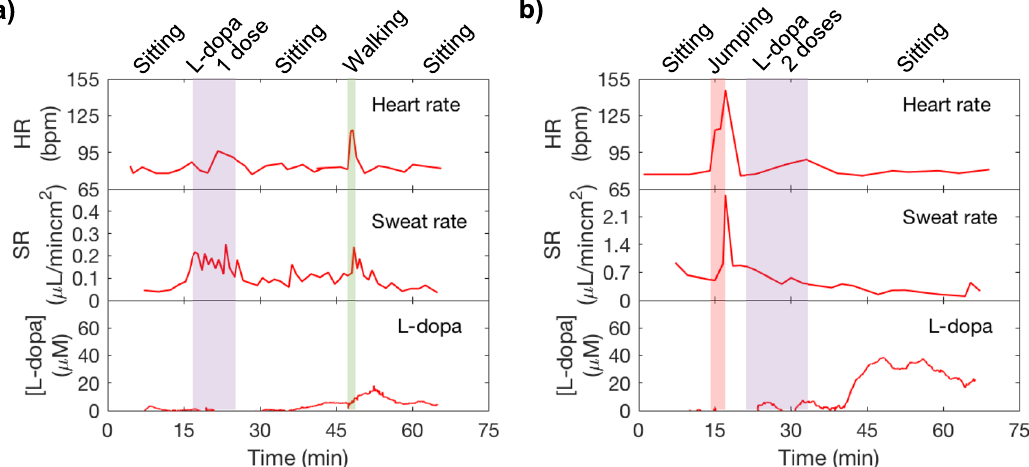
Fig. 7 In situ sweat analysis to assist Parkinson ’ s disease management on daily basis. A healthy subject wore the micro fl uidic patch on the fi nger and had broad beans intake of ( a ) 1 dose = 100 g and ( b ) 2 doses = 200 g during the measurement duration. (levodopa =